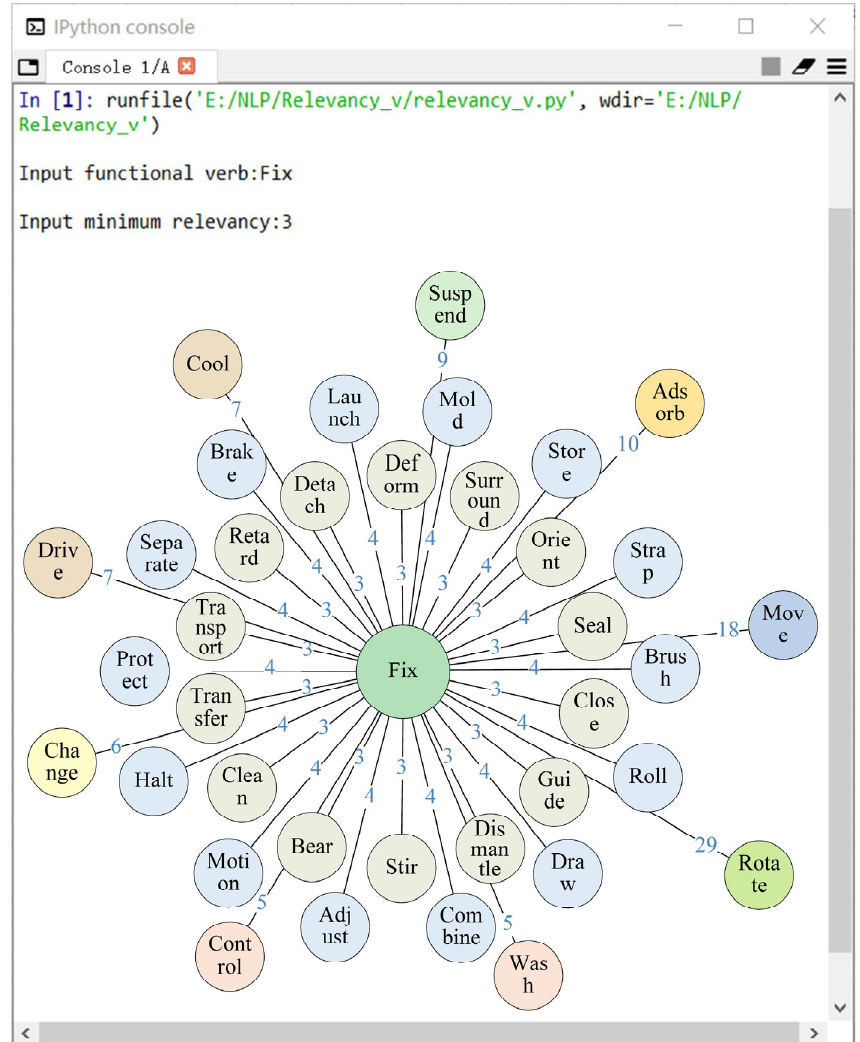
Figure 11. Search for associative verbs.